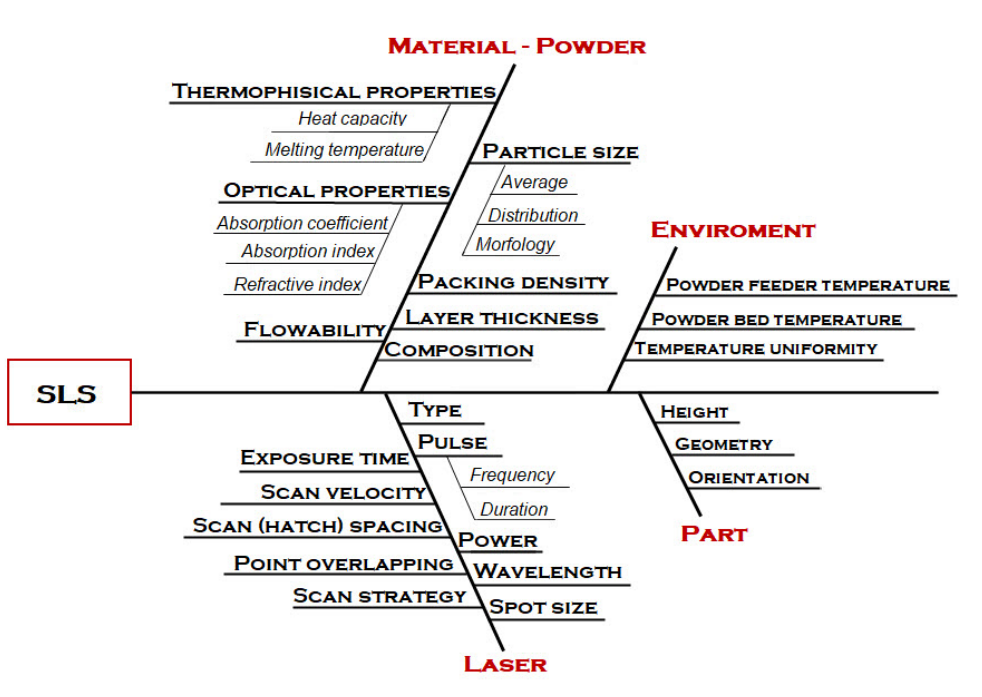
Figure 18. Ishikawa diagram of SLS process parameters.